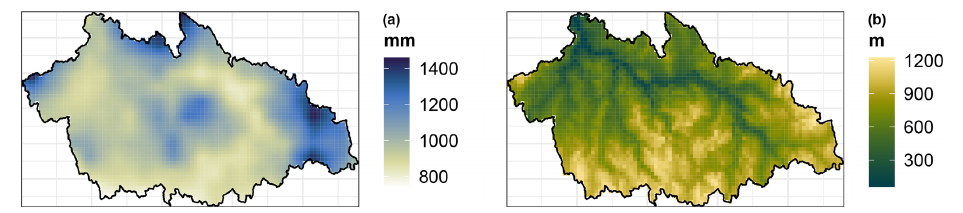
Figure 5. Average annual precipitation (a) in the period 1957–2005 and the digital elevation map (b) , both at the 1km × 1km scale in the catchment Gaulfoss.